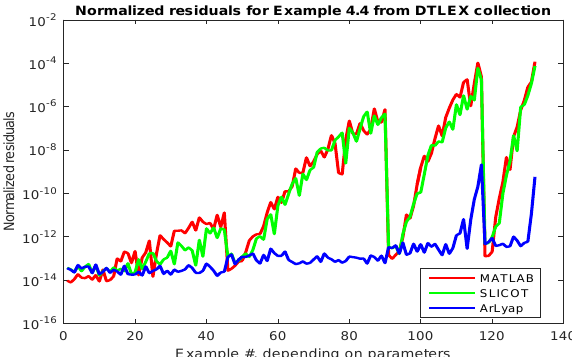
Figure 15. Normalized residuals for DTLEX 4.4 series of examples; tolerance ε 2 initialized by dlyap solution.